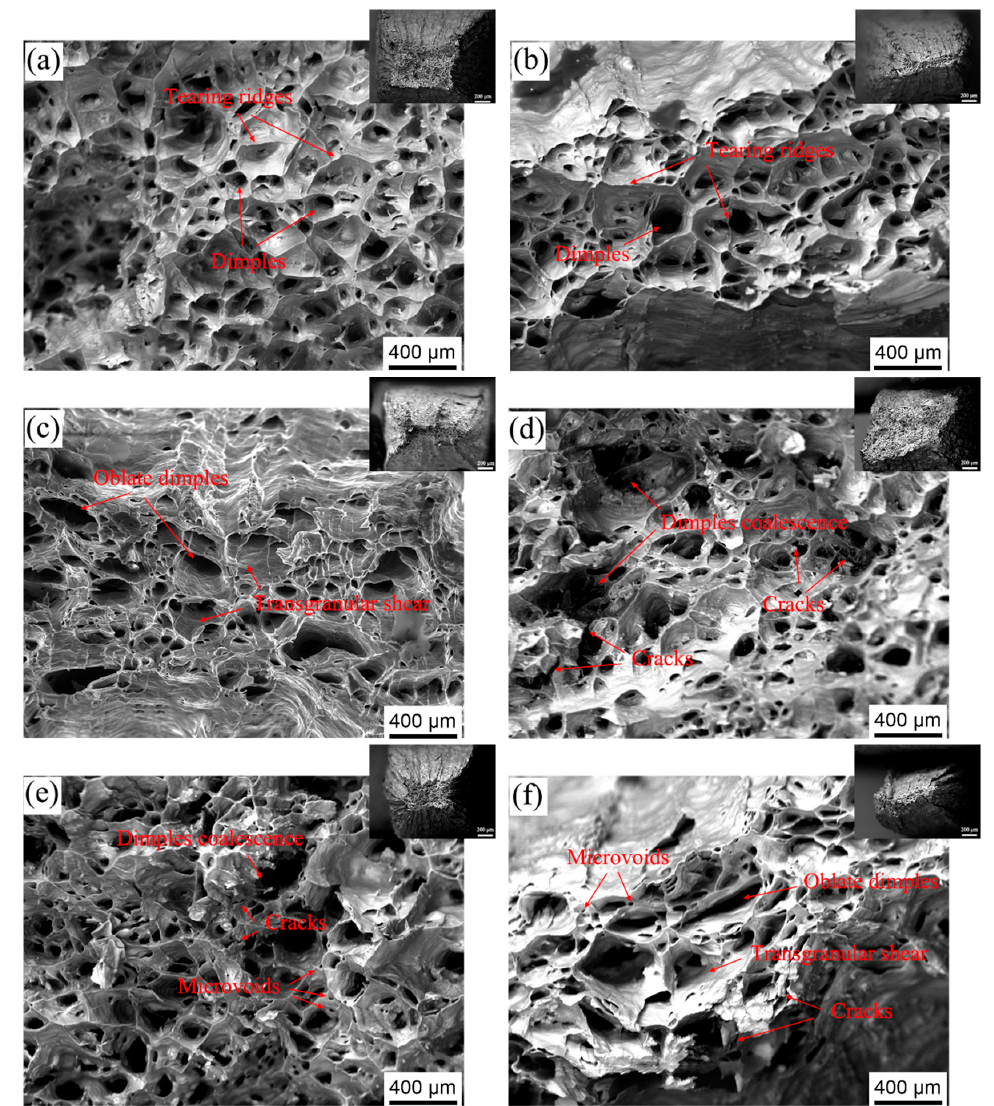
Figure 4. SEM fractographs of the 0Cr18AlSi steel tested at different conditions: ( a ) 973 K and 1.7 × 10 − 2 s − 1 ; ( b ) 1023 K and 1.7 × 10 − 2 s − 1 ; ( c ) 1123 K and 1.7 × 10 − 2 s − 1 ; ( d ) 873 K and 1.7 × 10 − 4 s − 1 ; ( e ) 973 K and 1.7 × 10 − 4 s − 1 ; ( f ) 1073 K and 1.7 × 10 − 4 s − 1 . The insets indicated the fracture surfaces at low magnifications.